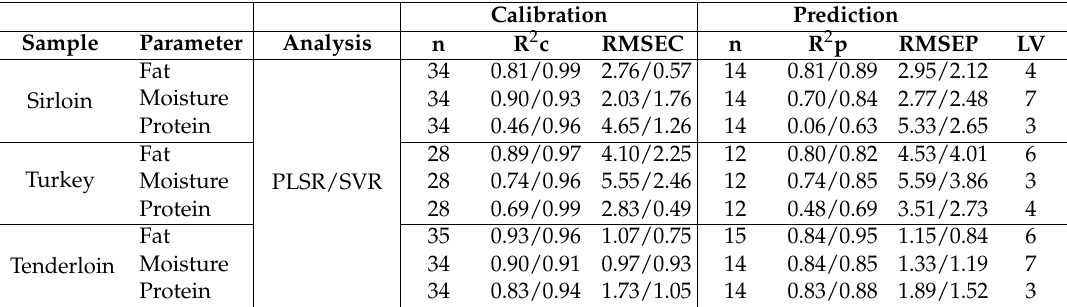
Table 2. Chemical component prediction in meat samples based on multispectral imaging with standard normal variate (SNV) preprocessing method.